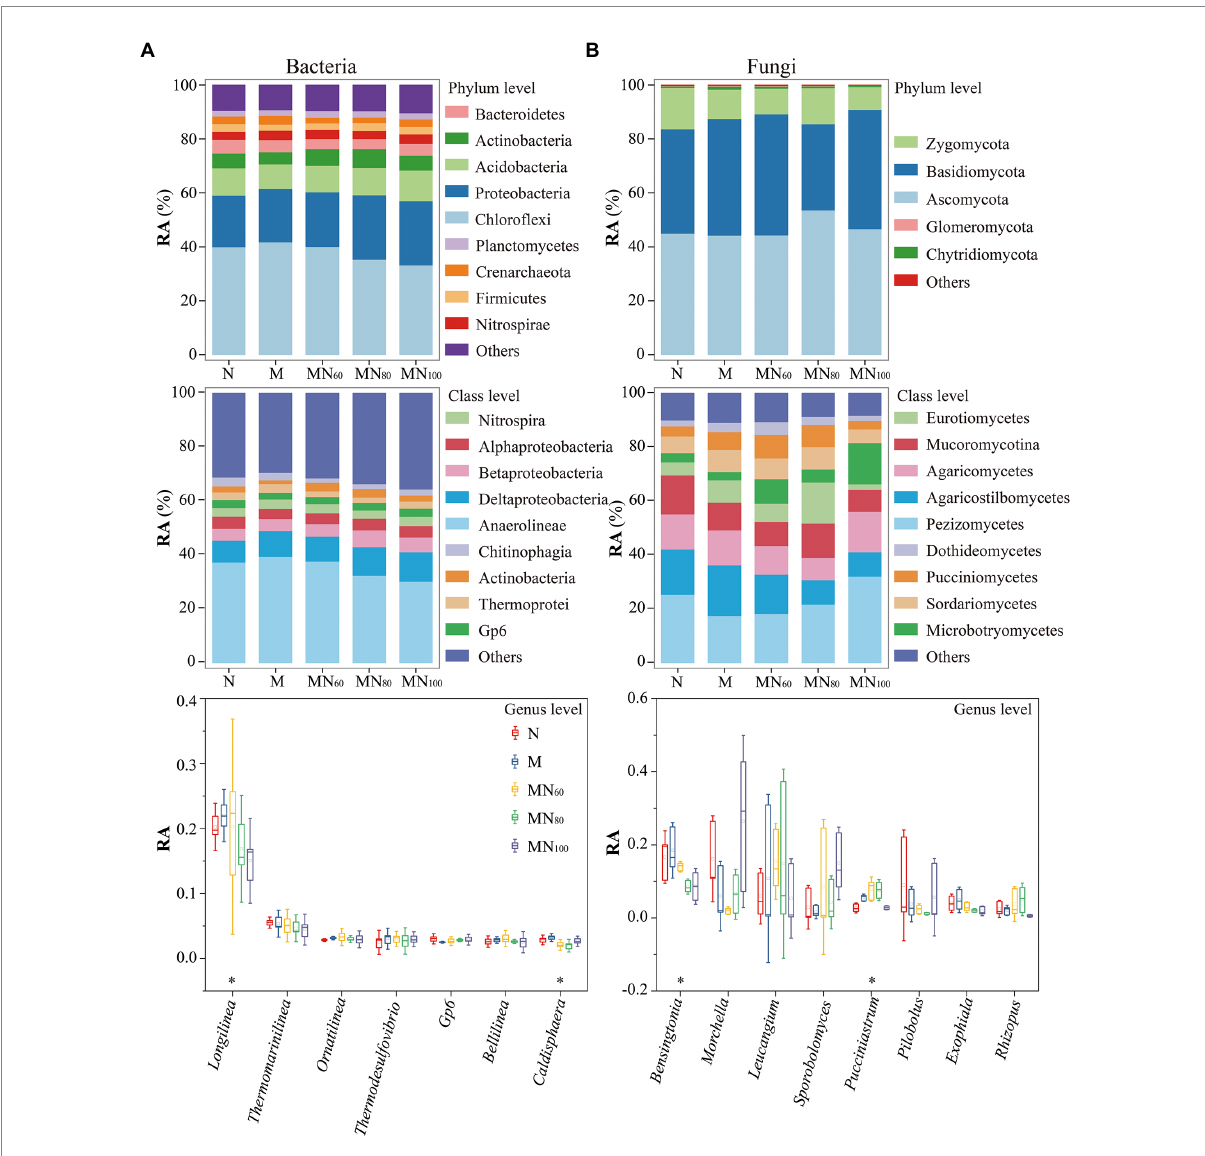
FIGURE 3 Soil microbial communities under different fertilization measures. A,B show the composition and abundance of soil bacteria at the taxonomic levels of phylum, order and genus, respectively. RA: Relative abundance. * p < 0.05 indicates that the relative abundance of taxa at the genus level differed significantly under different fertilization